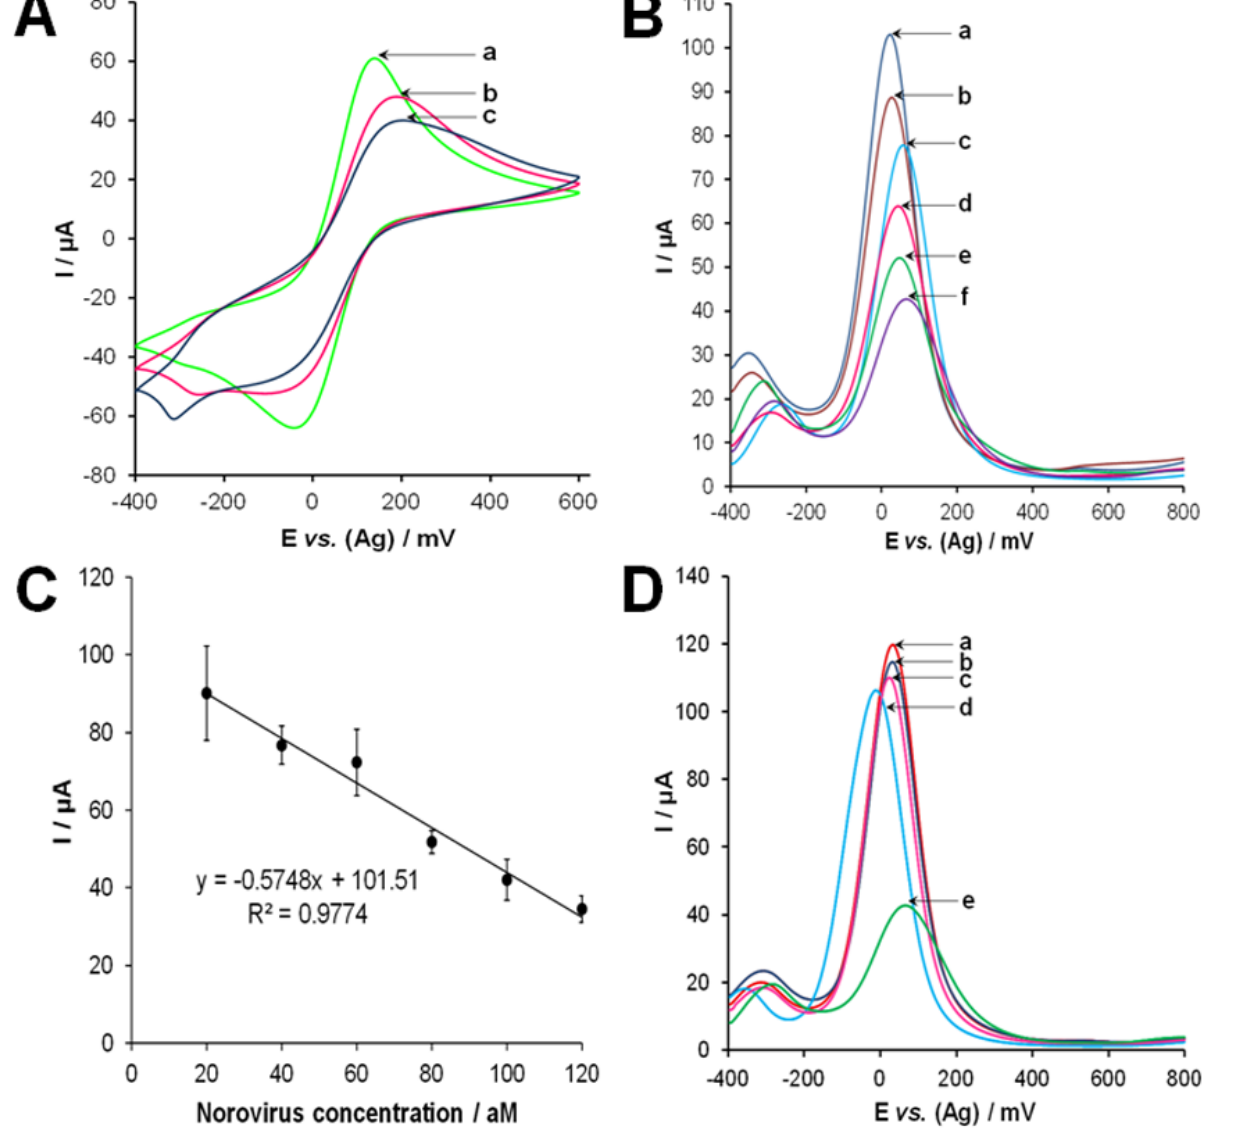
Figure 4. Aptasensor results. (A) Cyclic voltammograms of the norovirus aptasensor after each immobilization or binding step. The [Fe(CN) 6 ] 3 2 /2 2 redox couple was monitored for these experiments and cyclic voltammograms were recorded at a scan rate of 100 mV s ,–1 where ( a ) bare SPGE; ( b ) after self-assembly of the thiolated norovirus specific aptamer; ( c) after back-filling with 1 mM 2-mercaptoethanol. (B) Square wave voltammograms obtained using ( a ) 20 aM, ( b ) 40 aM, ( c ) 60 aM, ( d ) 80 aM, ( e ) 100 aM, and ( f ) 120 aM of norovirus in buffer. (C) Calibration plot of current vs. concentration of norovirus. (D) Selectivity experiments performed using (a) buffer alones, (b) 5000 PFU of vesicular stomatitis virus, (c) 5.1 mg mL 2 1 HSA, (d) 5000 PFU of vaccinia virus (e) 120 aM of norovirus. All experiments were performed in Dulbecco’s phosphate buffered saline after incubation with the developed aptasensor for 1 hr at 25 u C. Square wave voltammograms were carried out in the range of 2 400 to 800 mV with a step potential of 4 mV, amplitude of 5 mV and frequency of 10 Hz. Electrochemical measurements were performed in 25 mM phosphate buffer (pH 7),